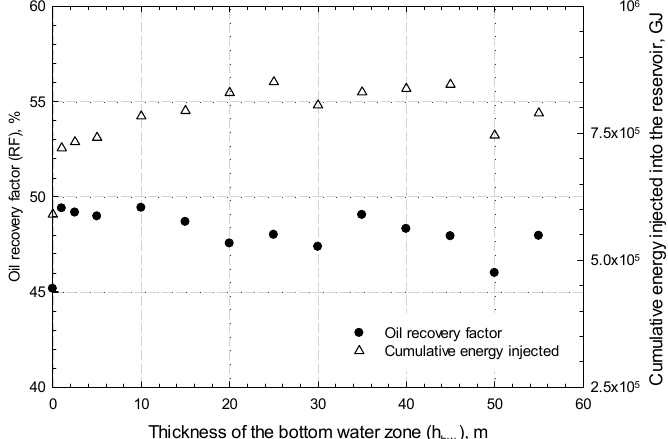
Figure 8. The oil recovery factor and cumulative energy injected into the reservoir under different thicknesses of the bottom water zone.